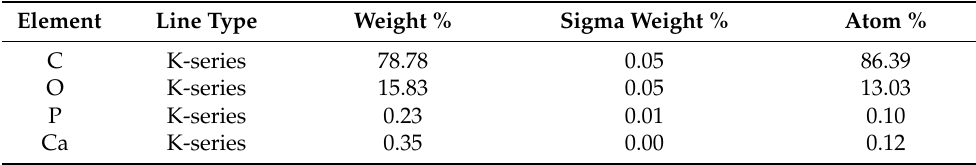
Table 3. Total spectrum of map and distribution of elements after 6